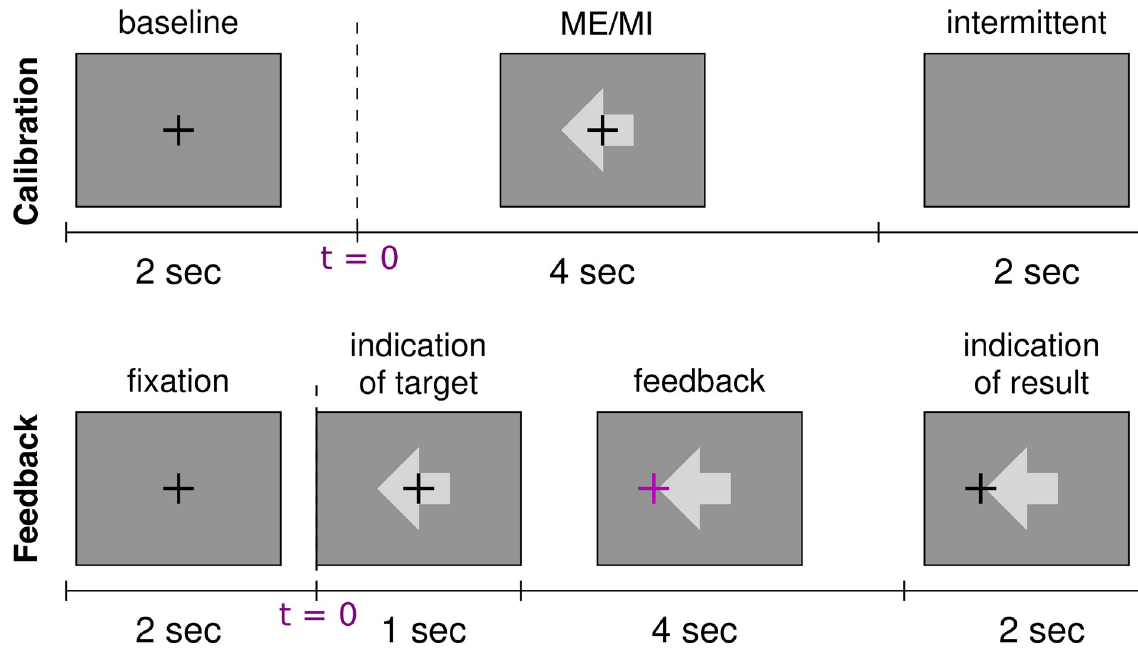
Fig 1. Trial design for calibration and feedback runs. First row: design of the trial for the ME and MI-Cb runs. The trial starts with a warning cue in the center of the screen in form of a cross at t = [ − 2 0] s (baseline or pre-stimulus interval). After 2 s (i.e. at t = 0), the stimulus appears in form of an arrow. The direction of the arrow indicates the task to execute: left for left hand movement, right for right hand movement, down for foot movement. After 4 s , cross and arrow disappear, and the screen stays blank for 2 s . Then a new trial starts. One trial lasts therefore 8 s in total. Second row: design of the trial for the MI-Fb runs. A fixation cross appears for 2 s (baseline or pre-stimulus interval) at t = [ − 2 0] s . At t = 0 the stimulus appears. After 1 s , the cross turns purple and starts to move depending on the classifier output (feedback). After 4 s the cross turns black again and freezes for 2 s while the result is visualized on the screen. One trial lasts therefore 9 s in total.